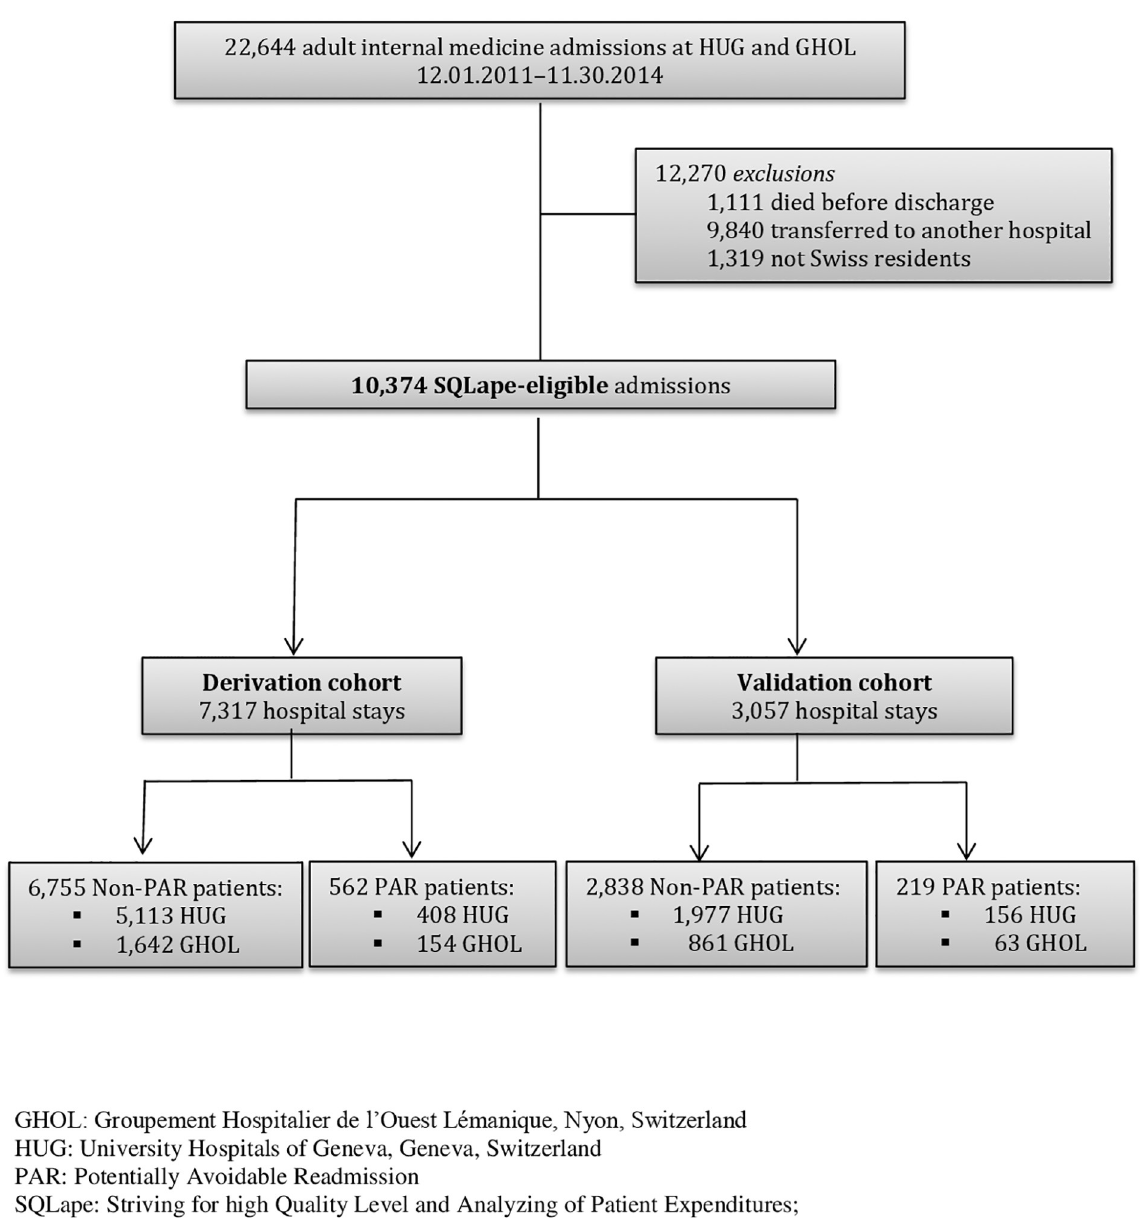
Fig 1. Study flowchart of all analyzed